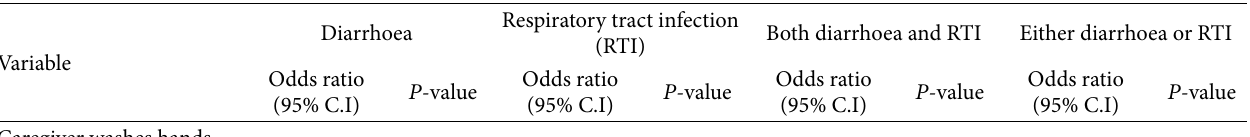
Table 6: Backward multivariate binary logistic regression of the determinants of diarrhoea and RTI morbidity among the 6–23 months